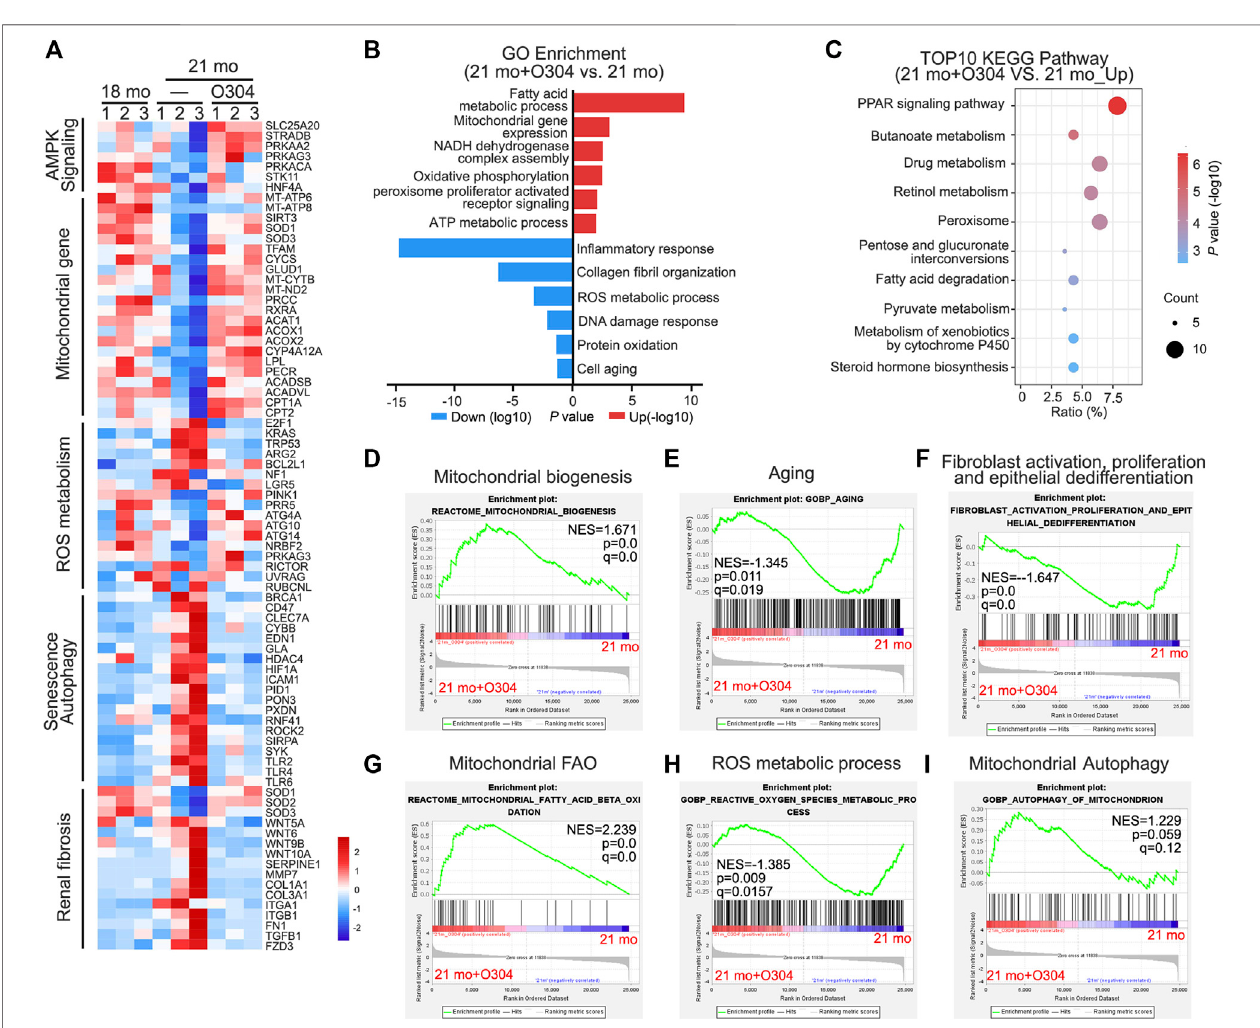
FIGURE 4 | Transcriptomic analysis further proves the effects of O304 on autophagy, fi brosis, senescence and energy metabolism in naturally aging mice. (A) Heatmapplot oftranscriptomic analysisshows the changes inthe AMPK signaling,mitochondrial genes,ROSmetabolism,senescence, autophagyand renal fi brosis in different groups. (B) Gene ontology (GO) analysis shows differentially expressed genes (DEGs) in 21mo vs 21mo/O304 mice. Red color indicates the upregulation of genes after O304 treatment, while blue color indicates the downregulation. (C) KEGG pathway analysis shows the top 10 target-pathways of O304 in the upregulatedgenesbyGOanalysis. (D – I) Geneset enrichment analysis(GSEA) showingthedifferentenriched genesin21-month-oldgroup orO304treatment group. q value meaning adjusted p value. NES, normalized enrichment score.